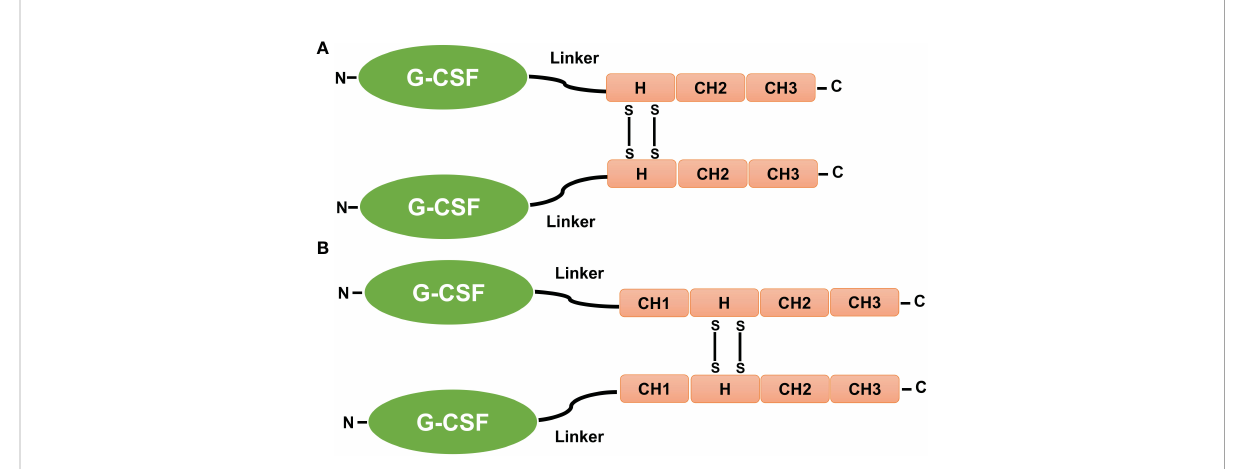
FIGURE 6 Fusion of G-CSF to Fc and CH domains. (A) The carboxy-terminus of human GCSF is fused to the amino termini of the IgG-Fc and IgG-CH domains by a 7 – amino acid fi xable linker (L). (B) The CH1, CH2, and CH3 sections of the IgG domains, as well as the hinge (H), are also shown. The presence of disul fi de bonds (SS) that occur between cysteine residues causes fusion proteins in the IgG hinge region to be dimeric (15,